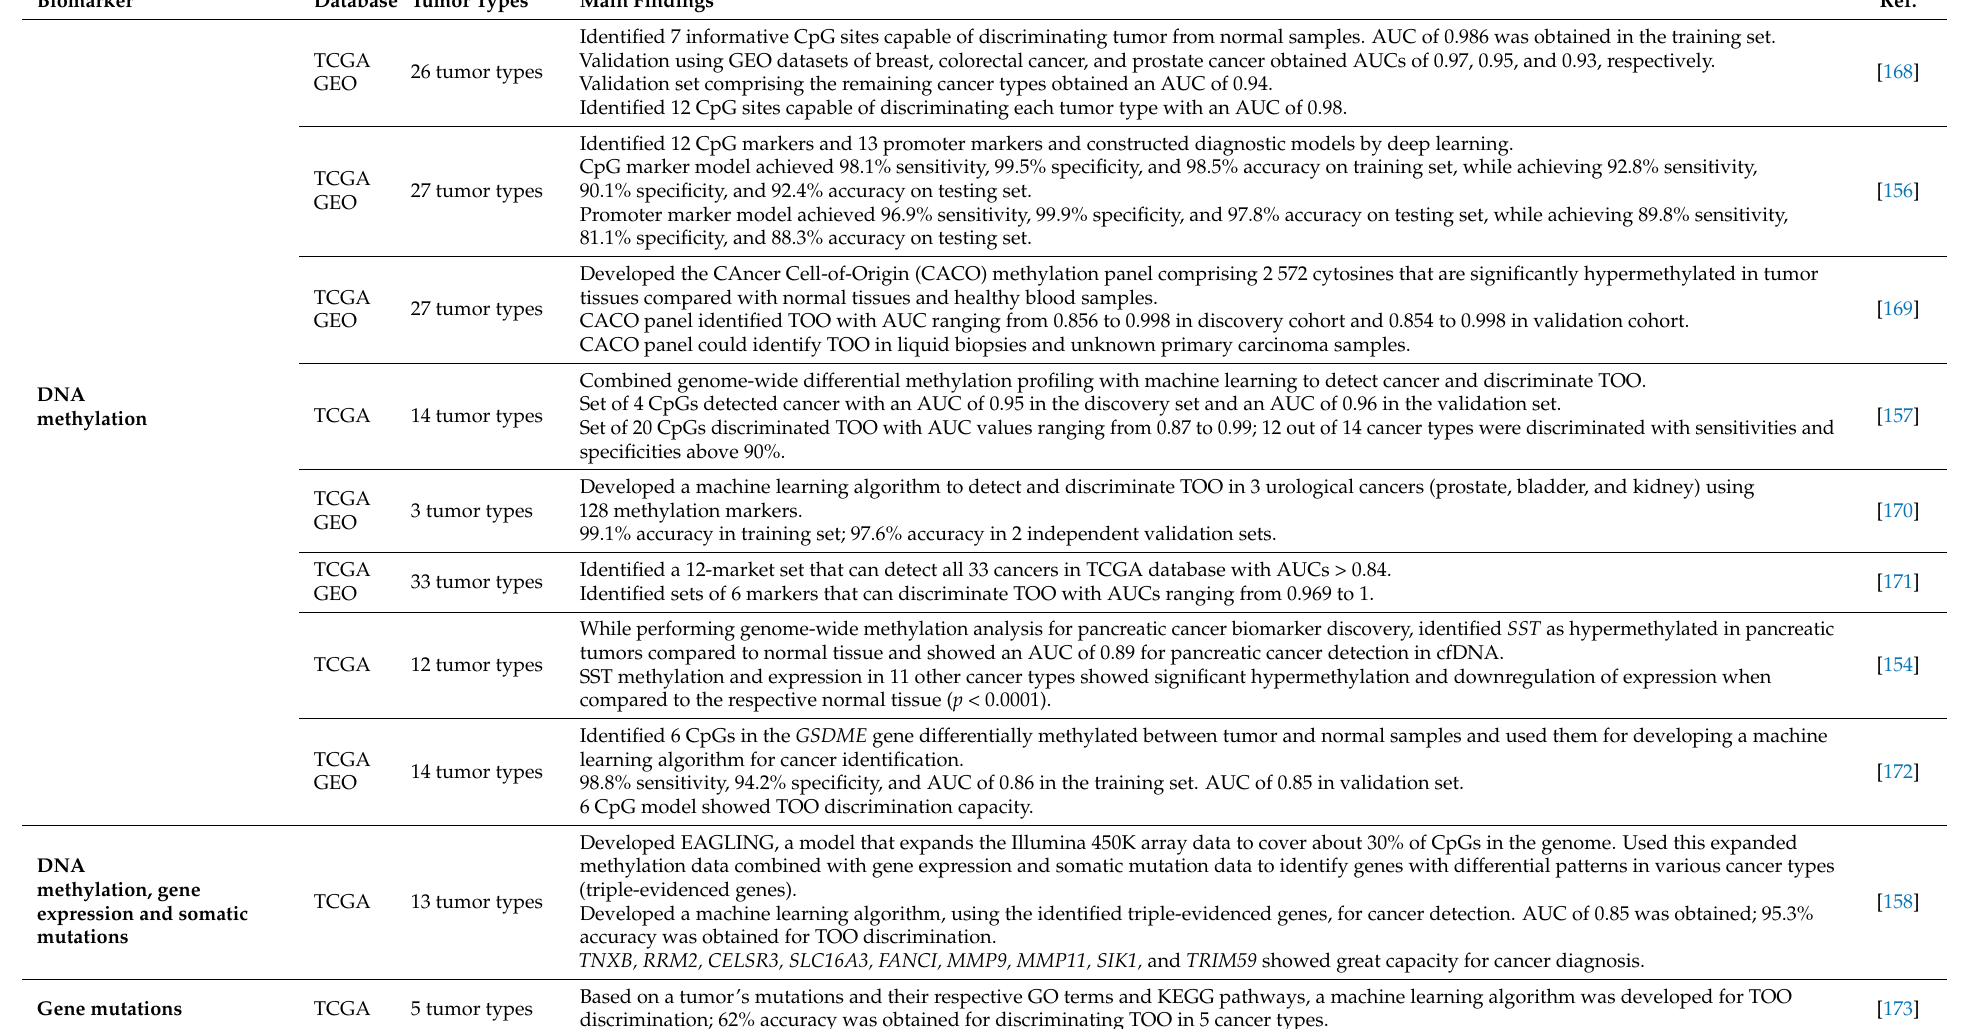
Table 2. Data mining studies of multi-cancer early